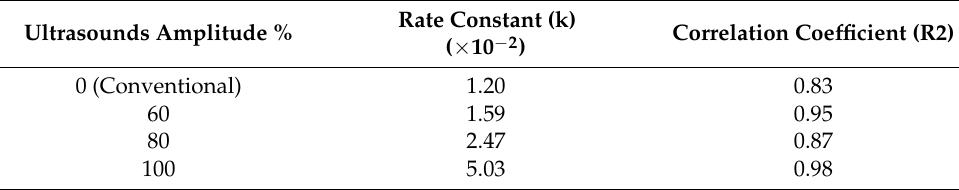
Table 2. Reaction constant rates obtained for ultrasound-assisted liquefaction of cork (Adapted from [78]). Rate Constant Ultrasounds Amplitude %